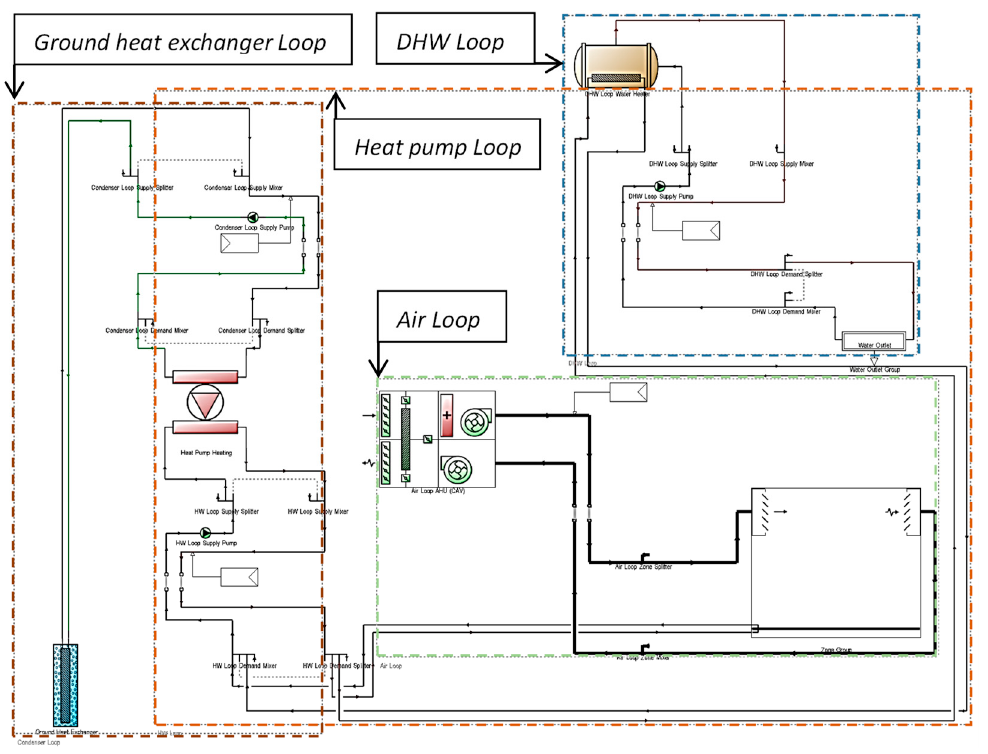
Figure 3. The ground source heat pump system used for heating applications cooperating with a mechanical ventilation system and a heat recovery component.